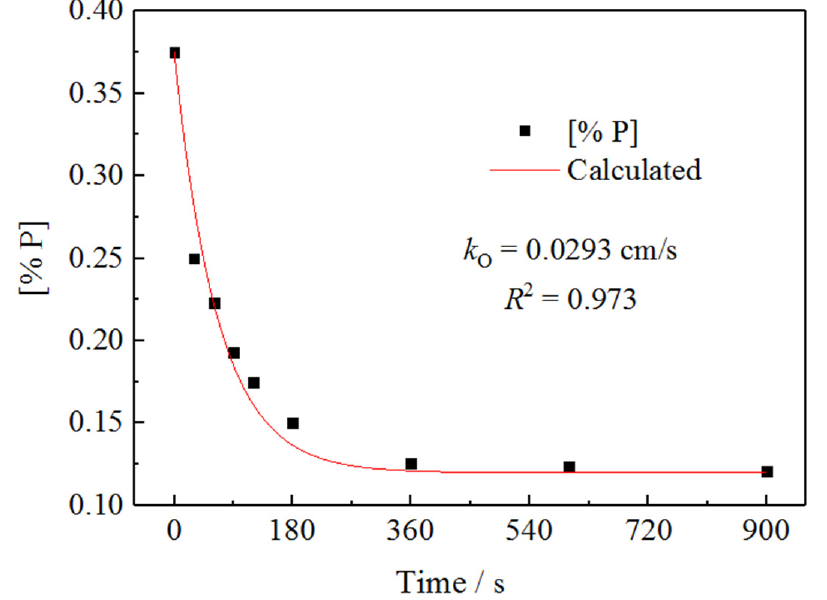
Figure 2. Fitting of Mori’s dephosphorization data (old model reprinted from Ref. [12]).